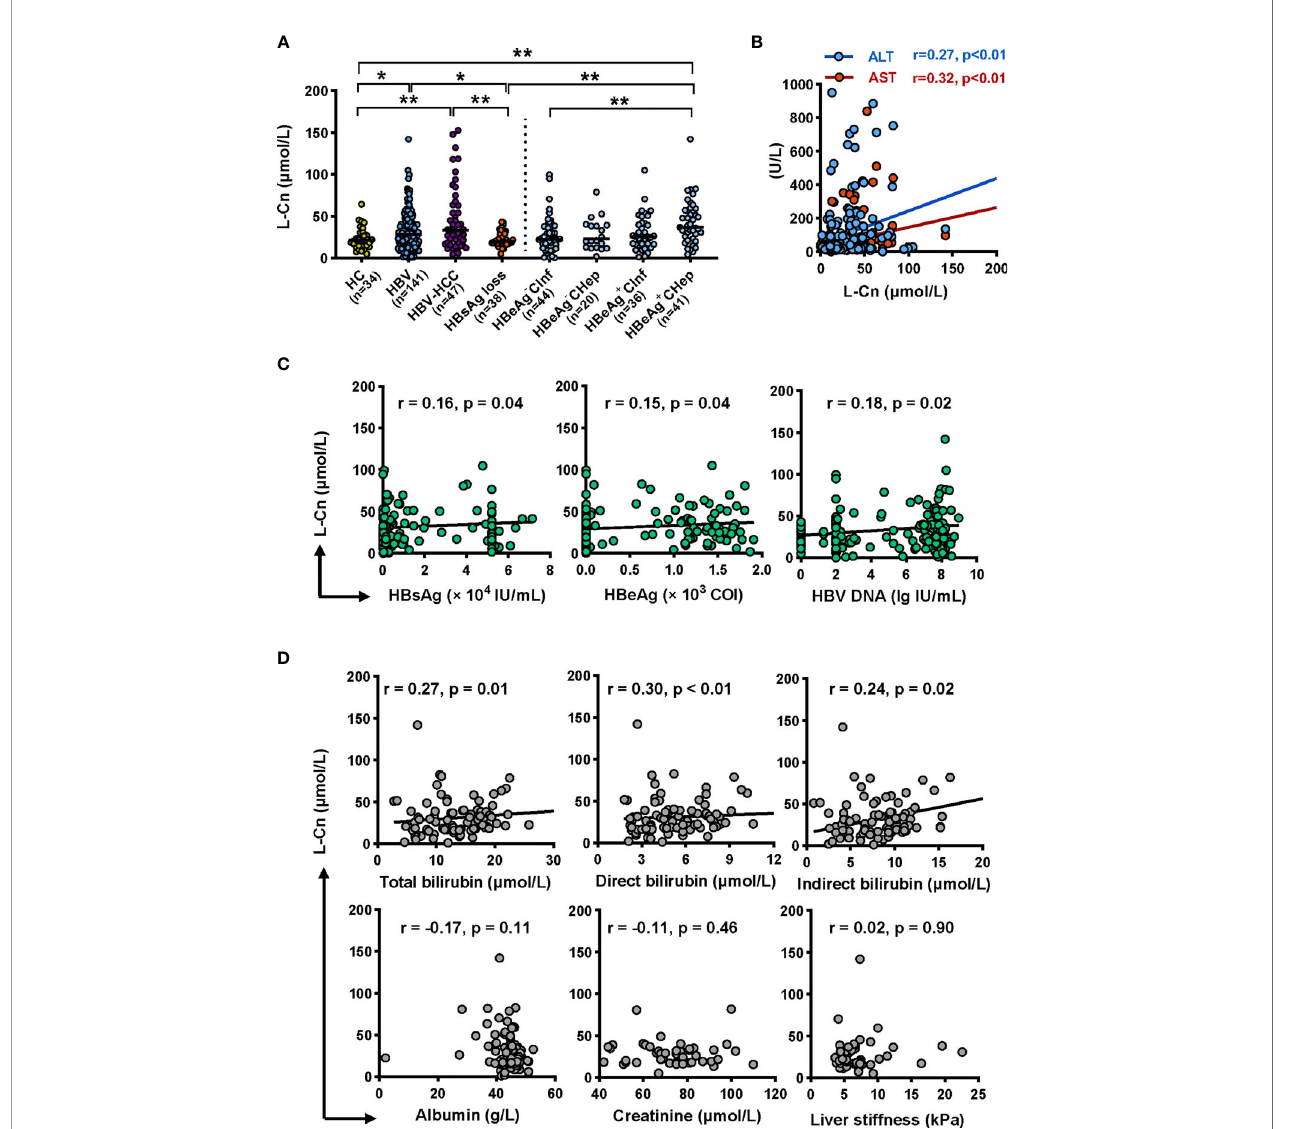
FIGURE 1 | Analyses of the L-Cn levels in cross-sectional cohorts. (A) Comparing plasma L-Cn levels within patients with chronic HBV infection, HCC, HBsAg loss, and HCs. (B) The correlation between the plasma L-Cn levels and serum levels of ALT or AST. (C) Spearman correlation between the levels of plasma L-Cn and the levels of serum virological parameters. (D) Spearman ’ s correlation between plasma L-Cn levels and the levels of serum biochemical parameters and the value of liver stiffness. (A) Mann-Whitney U test or Kruskal-Wallis H test and Dunn ’ s multiple comparisons test. (B – D) Spearman ’ s rank correlation test. * P < 0.05, ** P < 0.01. ALT, alanine aminotransferase; AST, aspartate aminotransferase; HCC, hepatocellular carcinoma; HCs, healthy controls; L-Cn,